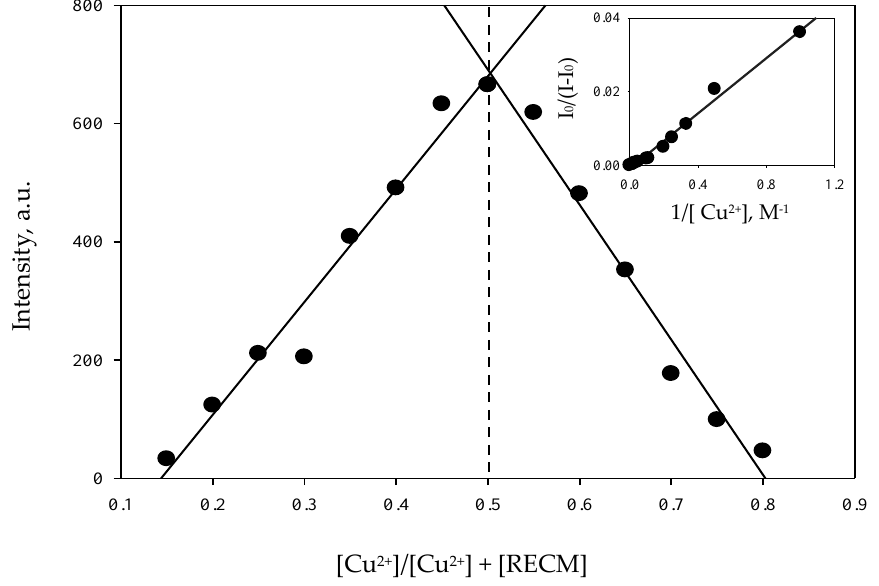
Figure 7. The binding stoichiometry of the RECM–Cu 2+ complex, according to the job plot method. Inset: the Benesi–Hildebrand plot result to evaluate K a of the RECM–Cu 2+ complex.